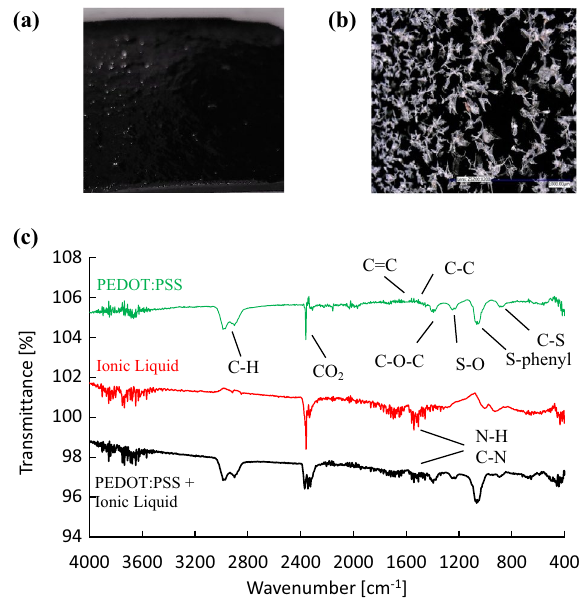
Figure 2. ( a ) PEDOT:PSS cathode, ( b ) SEM image of PEDOT:PSS film with 200 × magnification. ( c ) FTIR profiles of pure PEDOT:PSS, pure IL and IL-doped PEDOT:PSS, where typical band spectra are indicated and where it should be noted that the spectra are shifted (vertically) for better visualization.